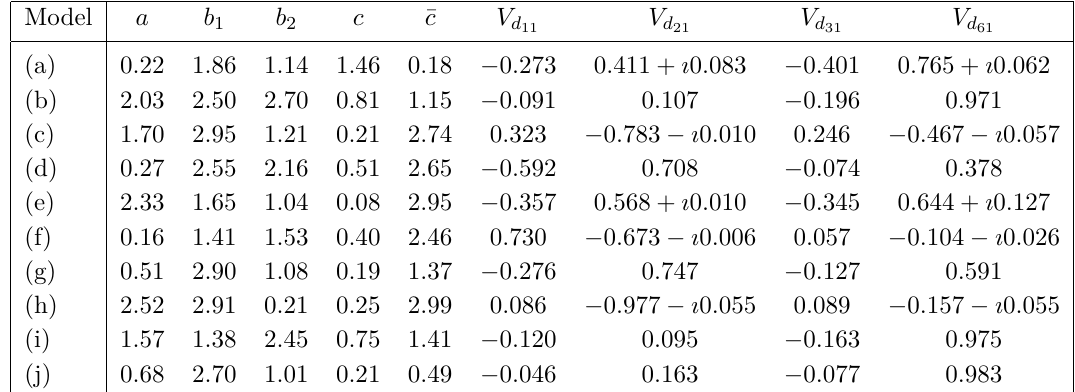
A numerical estimate of the elements of the up Higgs zero mode eigenvector using the analysis of table 1 and the couplings of eq. (2.3).